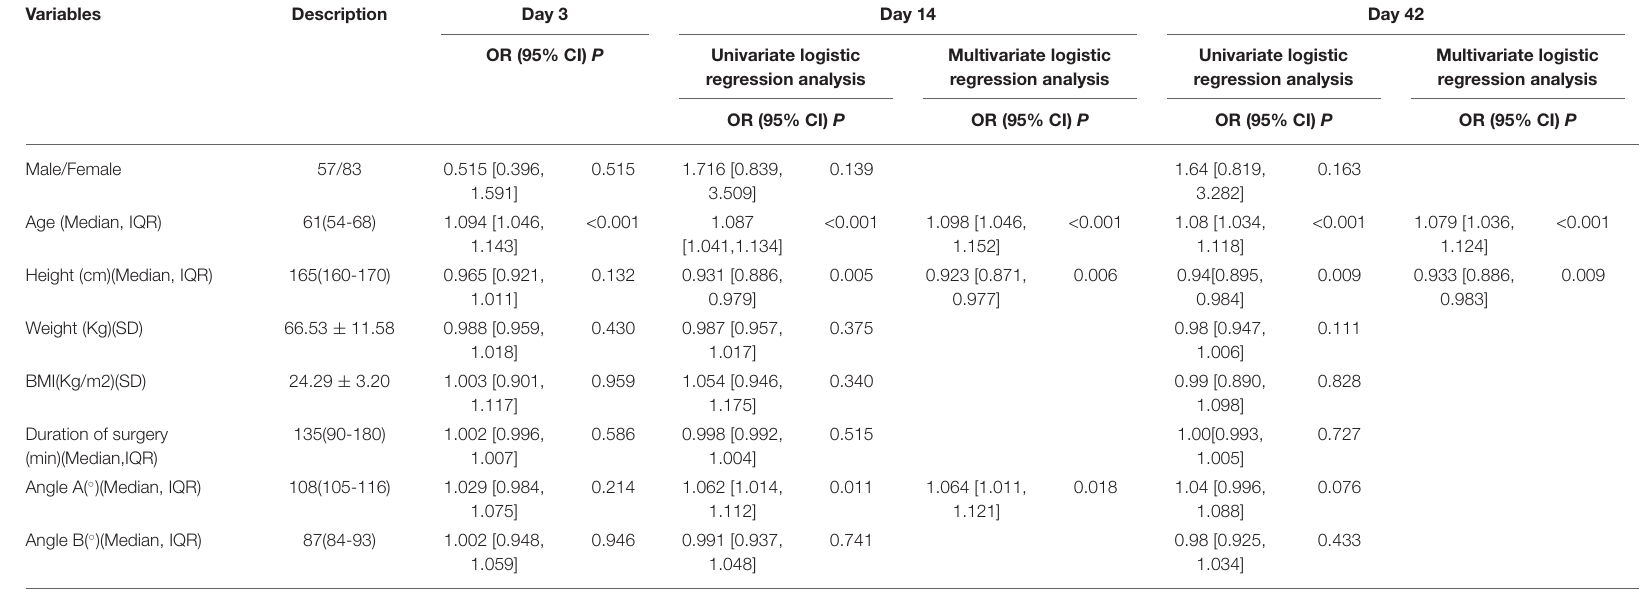
TABLE 1 | Descriptive statistics for the study